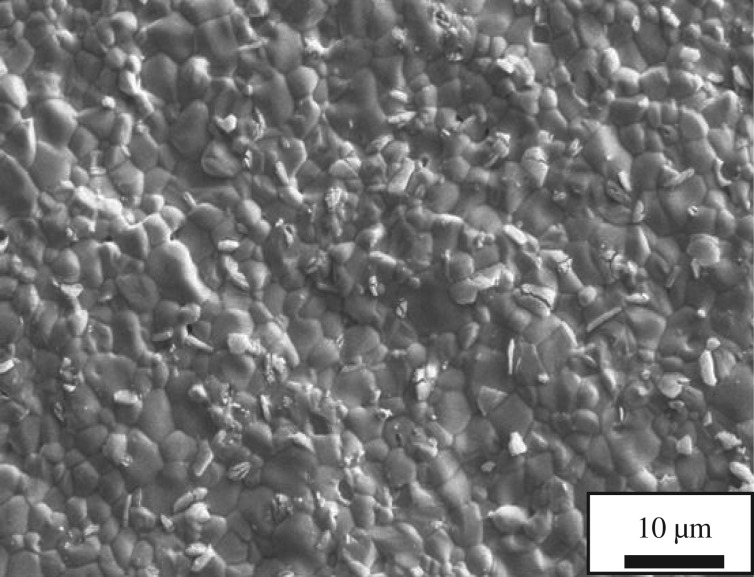
SEM micrographs of freshly prepared La2NiO4 surface.